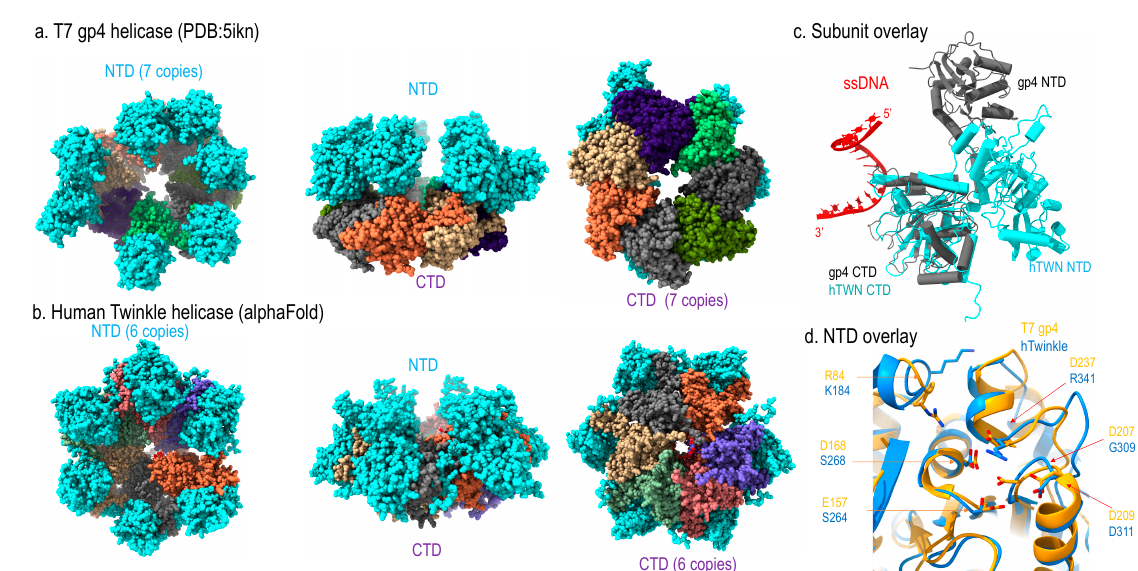
Figure 3. Structural comparison of human Twinkle helicase with T7 gp4 helicase ( a ) structure of apo heptameric gp4, the NTD is colored in cyan and CTD in multi-color, ( b ) Alphafold-predicted human helicase structure in similar color theme, ( c ) subunit structure of Twinkle (cyan) overlayed with T7 gp4 (grey), ( d ) Comparison of NTD structures of Twinkle (blue) and T7 gp4 (yellow).